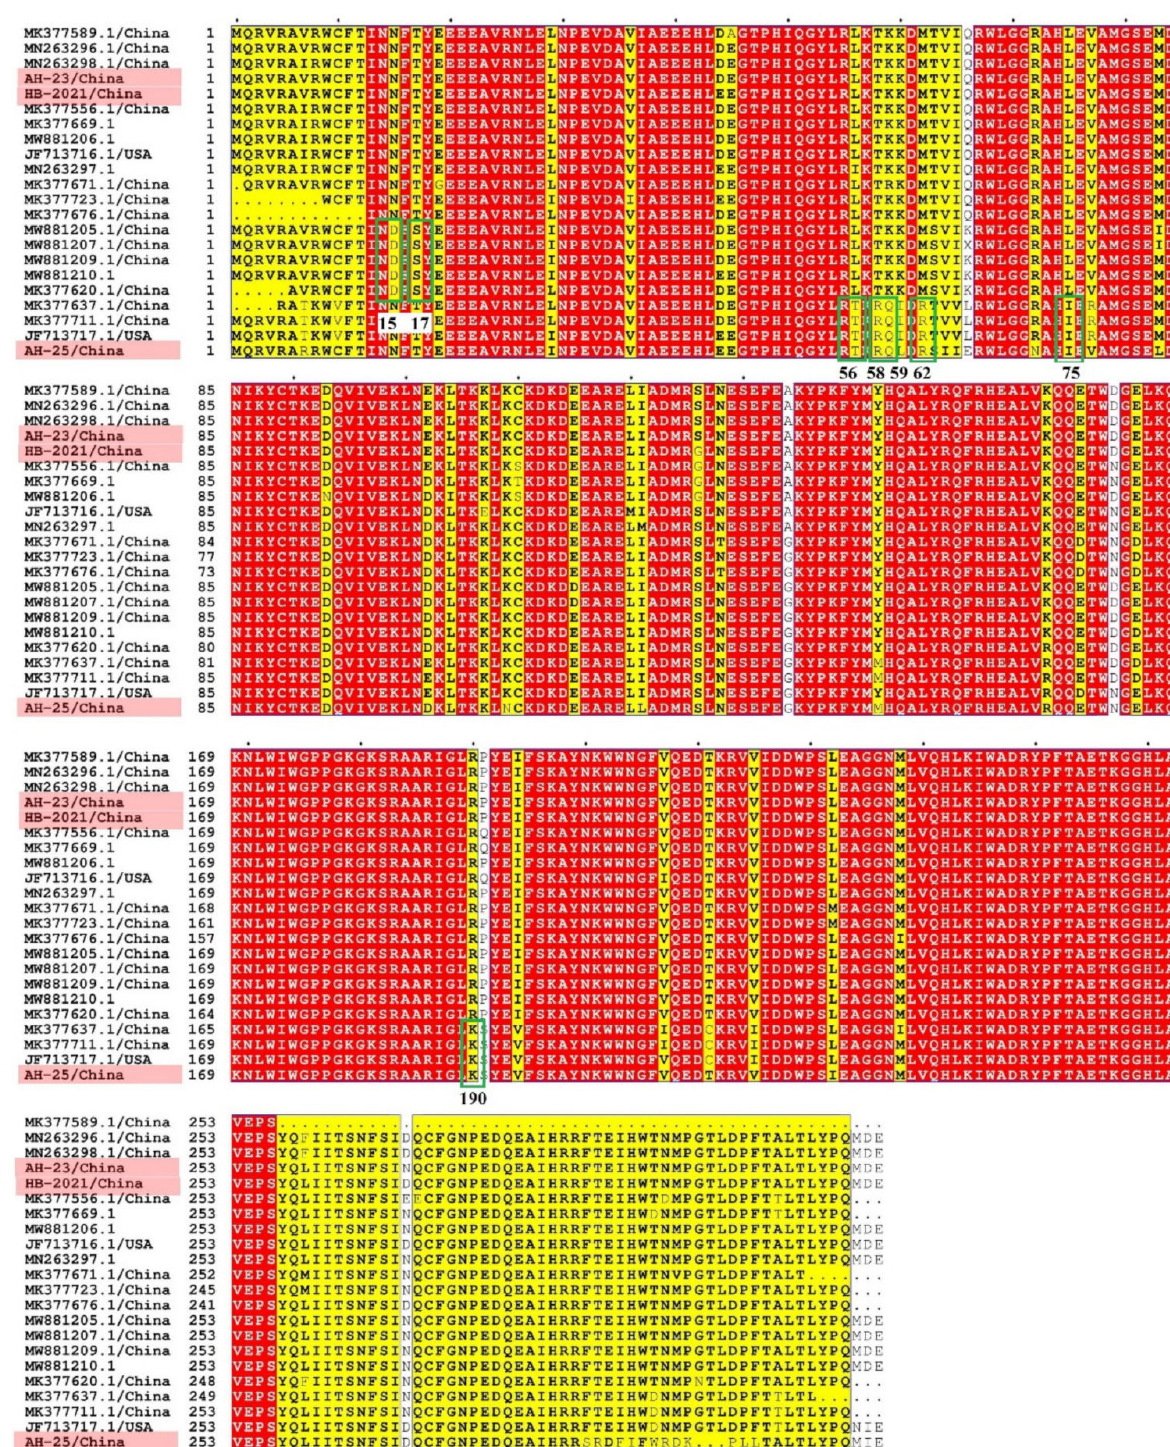
Figure 3. Amino acid mutation analysis of the PCLV Rep . Strains obtained in this study are indicated in pink. The conserved regions of the amino acid sequences are covered in